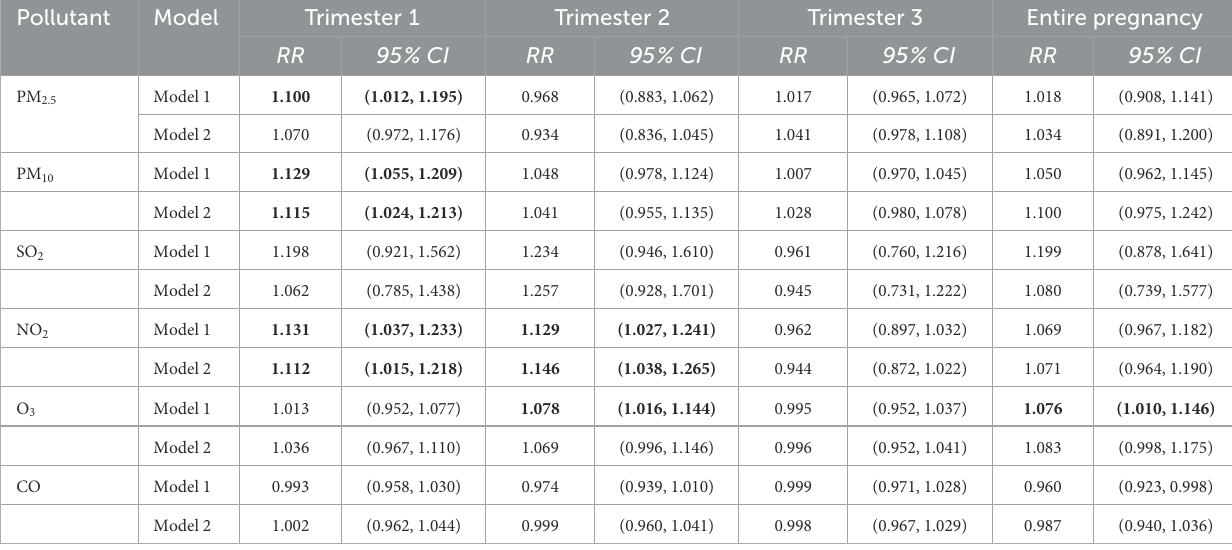
The bold face indicates statistical significance established at p < 0.05 in the above three models. Model 1: single-pollutant model, adjusted for covariates including mean temperature and humidity,ageofmotherandfather,andageofgestation;Model2:multi-pollutantmodel,adjustedforcovariatesincludingmeantemperatureandhumidity,ageofmotherandfather,weightof